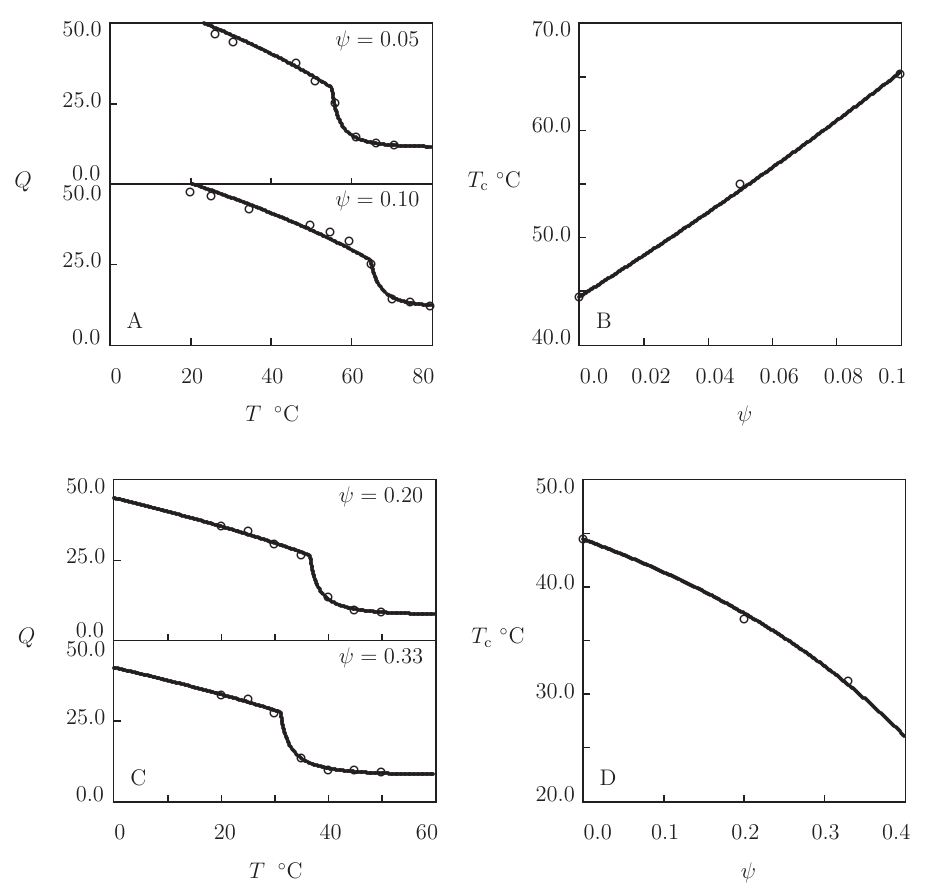
Figure 7. (A,C) Degree of swelling Q versus temperature T . Circles: experimental data [77] on P(DMAEMA-EAAm) ( A ) and P(DMAEMA-AAm) ( C ) gels with various molar fractions ψ of comonomers. Solid lines: results of simulation. ( B , D ) Volume phase transition temperature T c versus molar fraction ψ of comonomers. Circles: treatment of experimental data on P(DMAEMA-EAAm) (B) and P(DMAEMA-AAm) (D) gels. Solid lines: results of